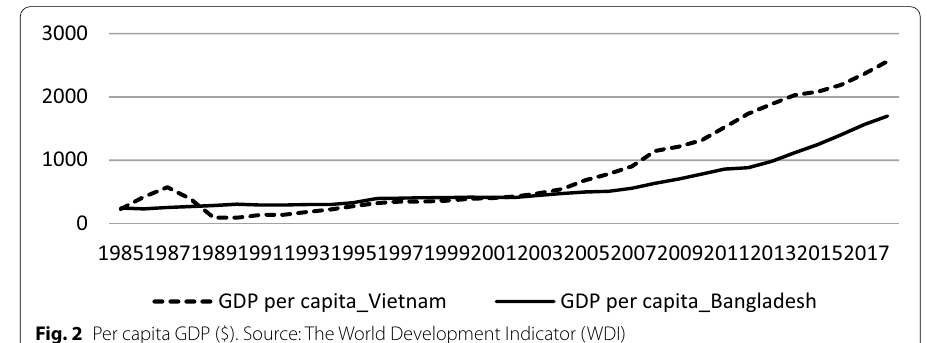
Fig. 2 Per capita GDP ($). Source: The World Development Indicator